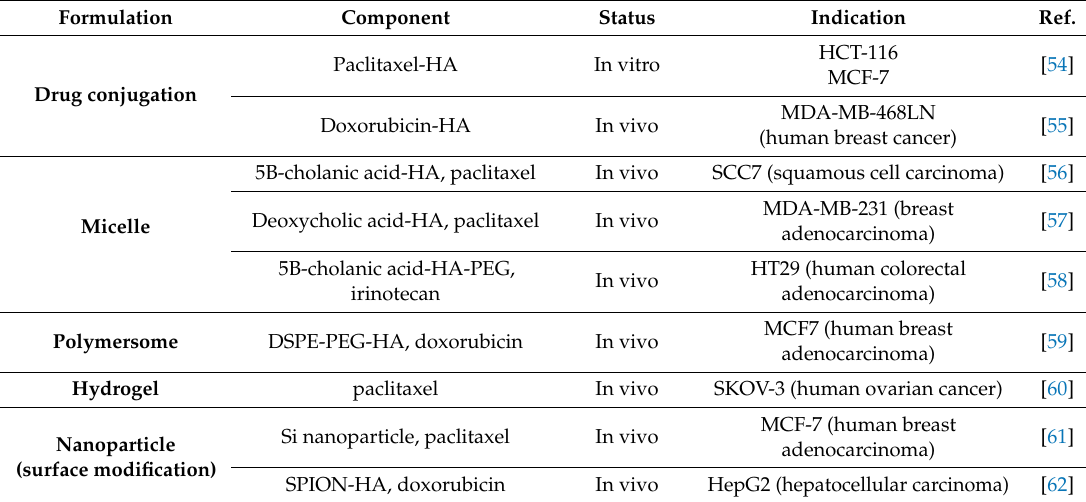
Table 1. Summary of recent principal research for chemotherapy using hyaluronic acid (HA)- based